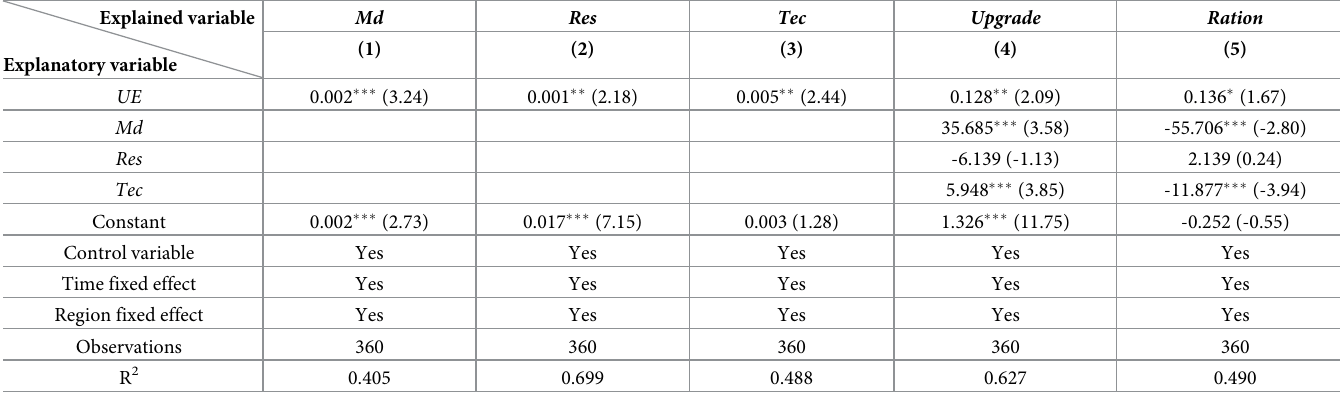
Table 5. Estimation results of the mediation